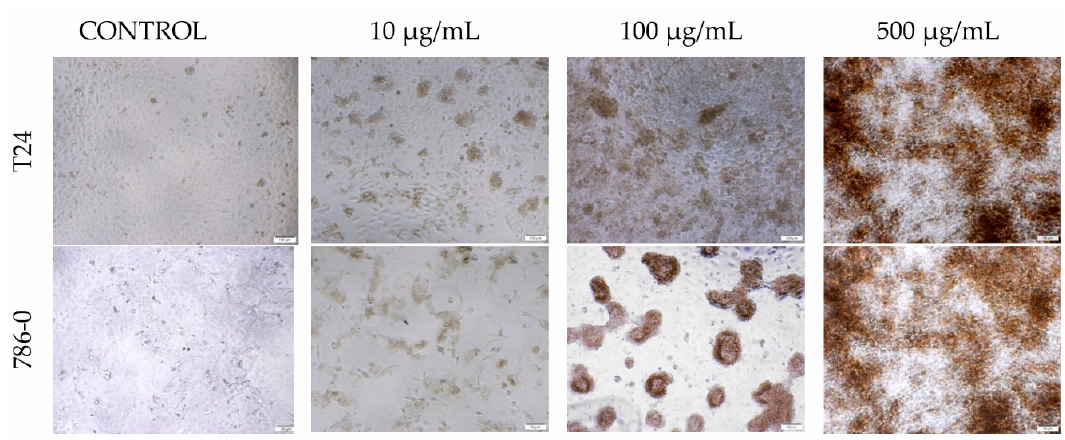
Figure 9. Morphology of T24 and 786-0 cells after 72 h incubation. Magnification × 50. In the case of the control group in the 10–500 µ g / mL range, large dark aggregates of GO molecules are noticeable. It can limit the cell growth surface.